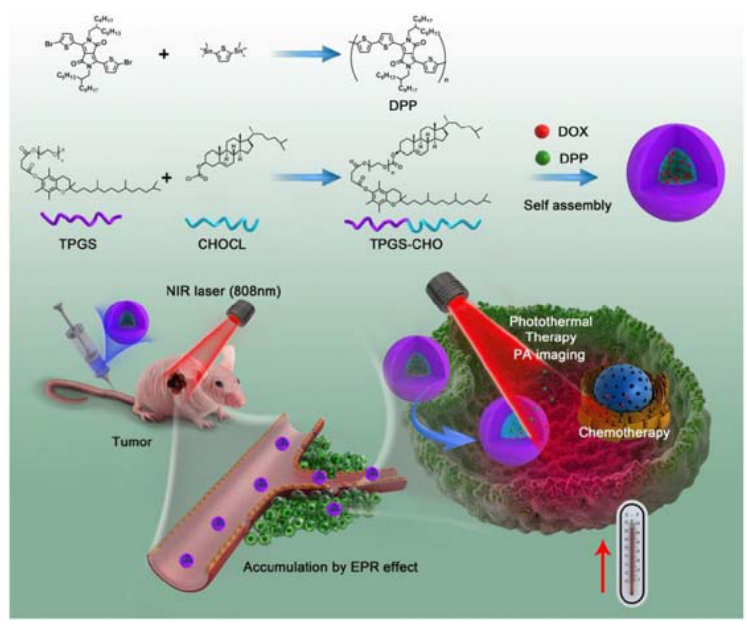
Figure 2 . Schematic of the synthesis and photoacoustic imaging ‐ guided photothermal/chemo combination Figure 2. Schematic of the synthesis and photoacoustic imaging-guided photothermal/chemo therapy micelle. Reproduced from [80] with permission from The Royal Society of Chemistry. combination therapy micelle. Reproduced with permission from [80]. The Royal Society of Chemistry,